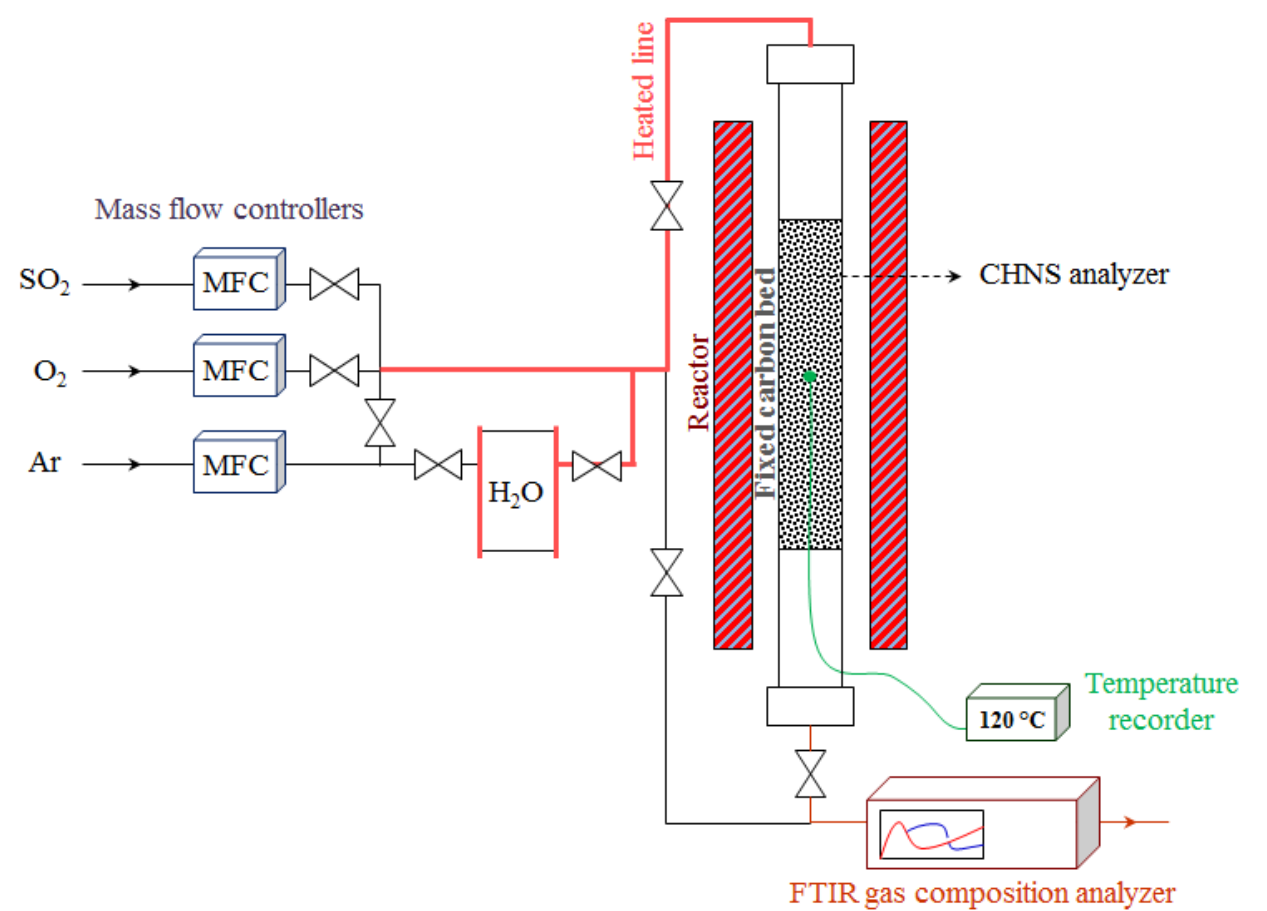
Figure 1. Scheme of the measuring system for SO 2 adsorption.